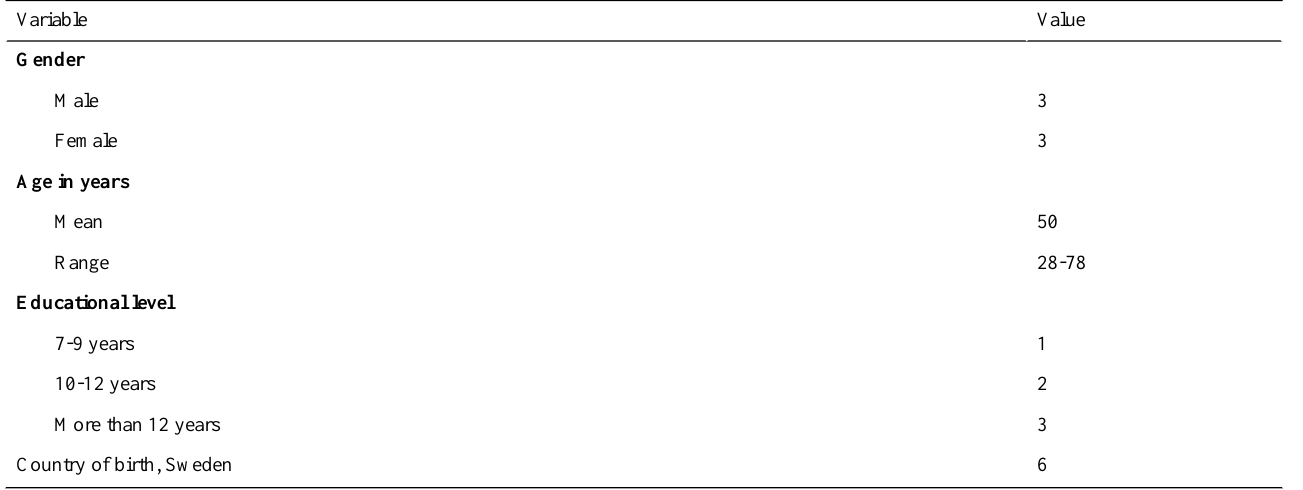
Table 1. Demographics of the content validity test group